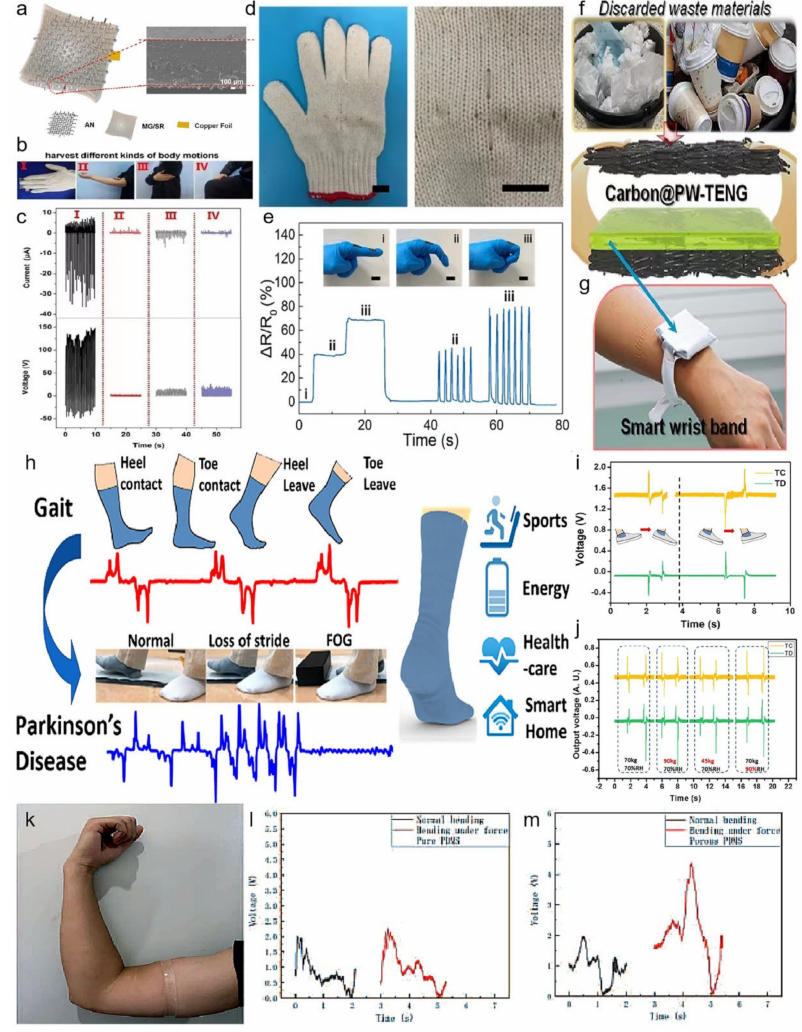
Figure 2. ( a ) Schematic diagram of flexible triboelectric nanogenerator (TENG) based on silicone rubber. The illustration is a cross-sectional view of the FE-SEM image of TENG. ( b , c ) Photographic images and corresponding output performance of TENG fixed at different positions of human